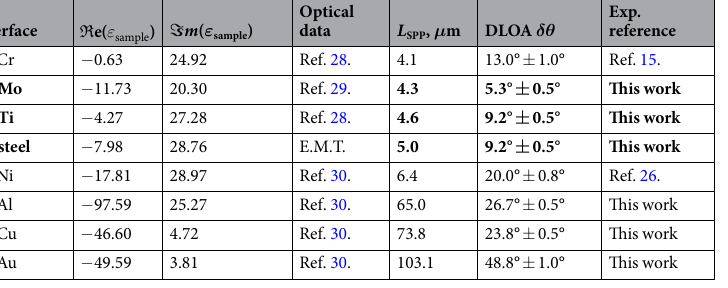
Optical data L SPP , μ m DLOA δθ